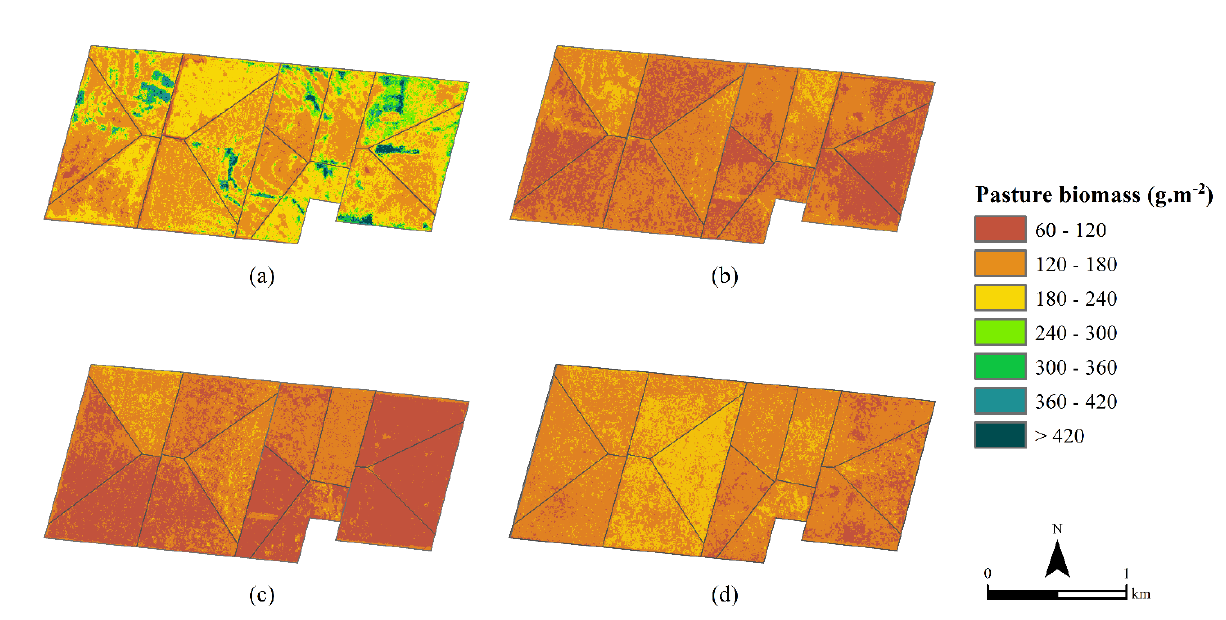
Figure 4. Pasture biomass spatial maps predicted by the best RF model for the study area in four dates: (a) 20 th May 2019, (b) 15 th June 2019, (c) 11 th July 2019, and (d) 10 th August